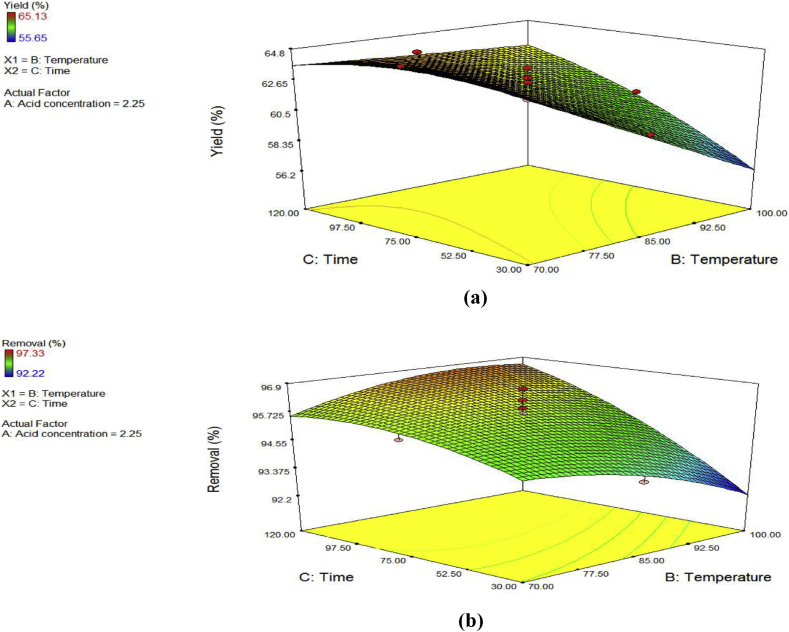
Effect of activation time and temperature on percentage (a) yield and (b) Pb2+ removal on HCl activated Aloji clay (constant acid activation = 2.25 M).